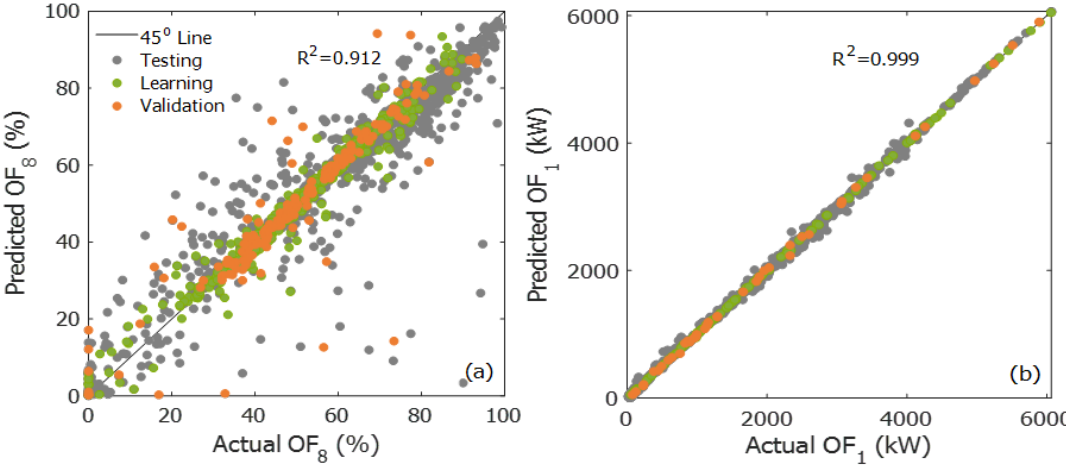
Figure 7. Predictions of ( a ) conversion in R-101 and ( b ) compression power in C-100.